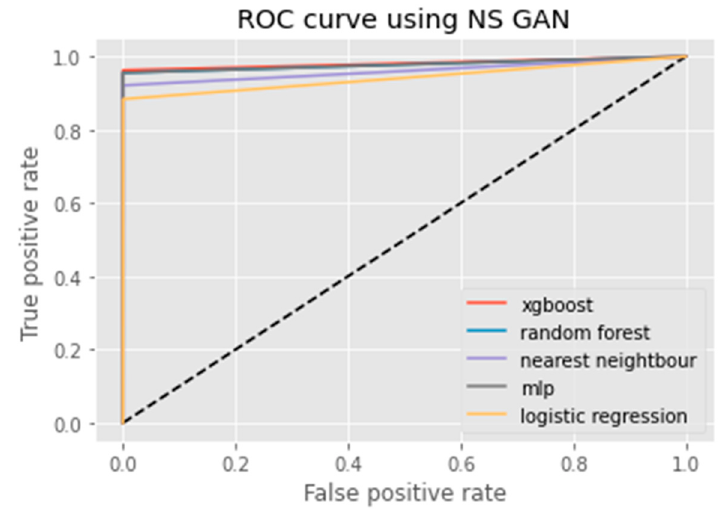
Figure 9. ROC curve using SDG GAN.